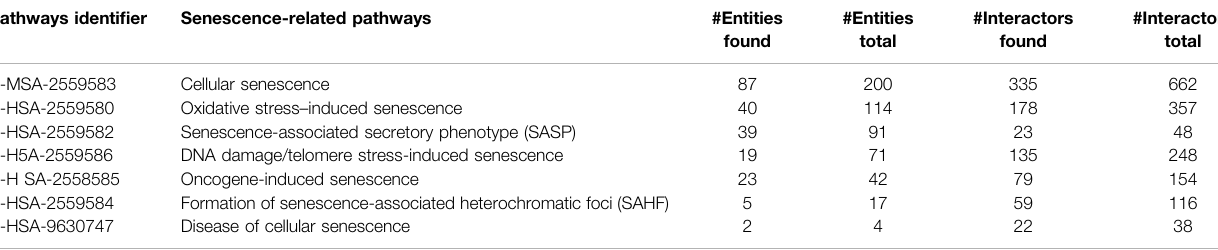
TABLE 2 | Senescence pathway from the common shared